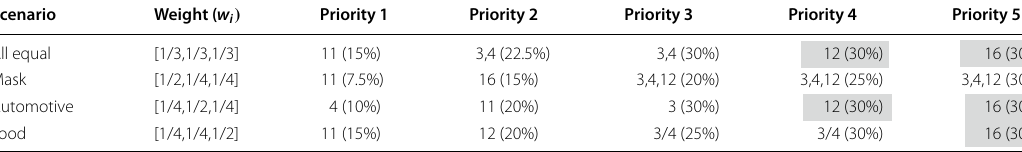
Table 1 Performance improvement with changing demands under a pandemic Scenario Weight ( w i ) Priority 1 Priority 2 Priority 3 Priority 4 Priority